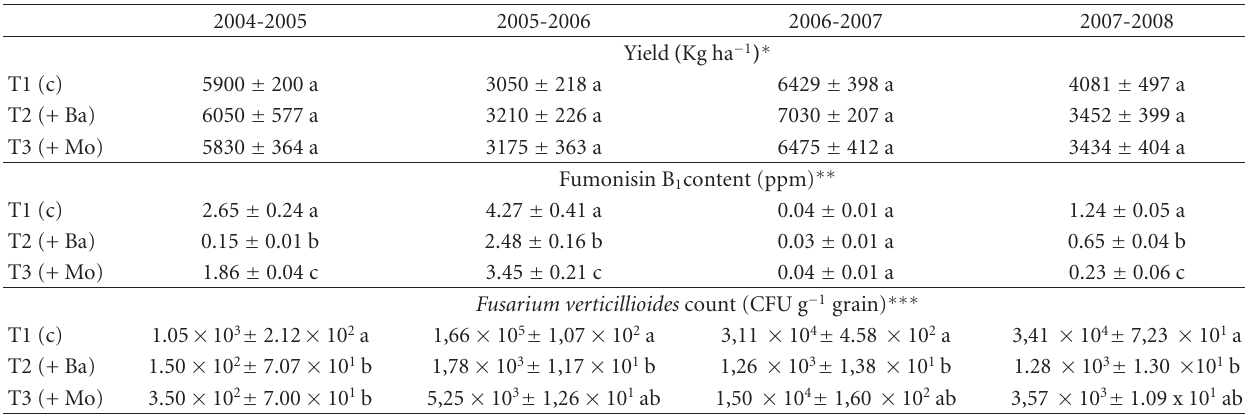
Table 3: Yield, F. verticillioides count and fumonisin contents of maize grains harvested during four consecutive growing